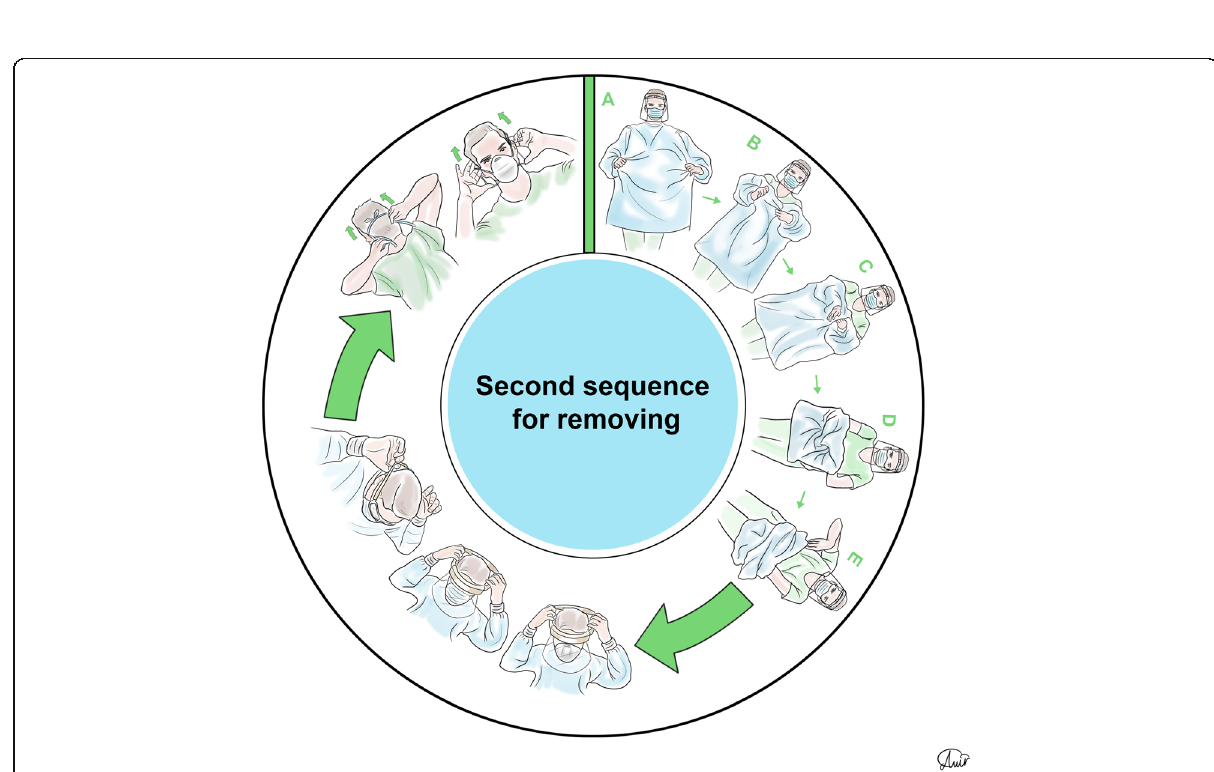
Fig. 4 Personal protection equipment doffing second